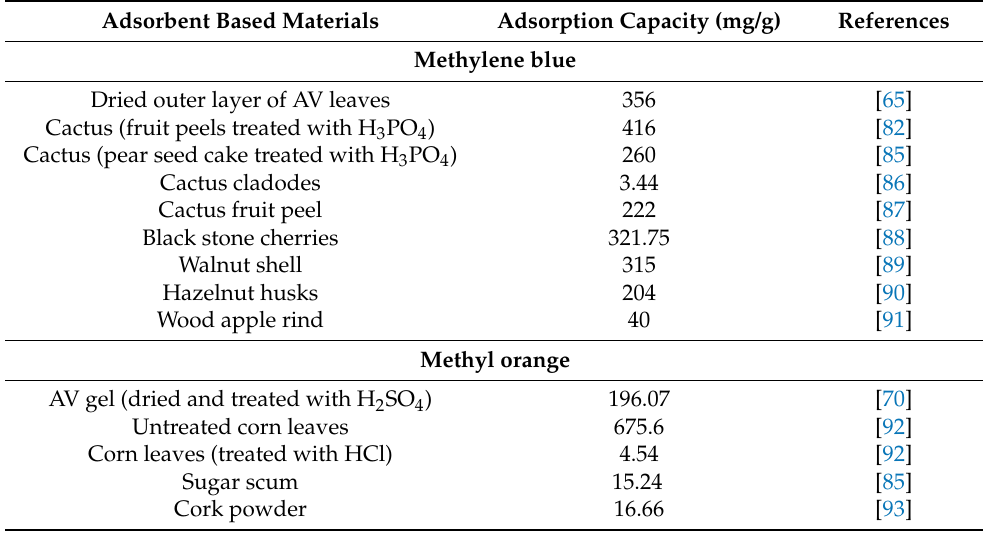
Table 4. Maximum adsorption capacity of Aloe vera based biosorbent compared to other natural products for methylene blue and methyl